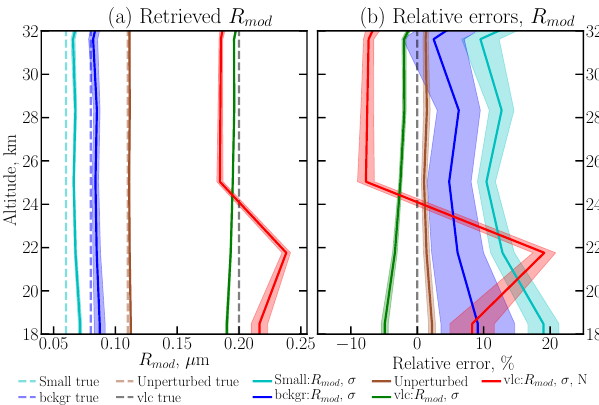
Figure 4. R mod profiles (a) and their relative errors (b) for a typi- cal tropical observation geometry. The solid lines show the retrieval results, while the dashed lines represent the true values. The shaded areas stand for ± 1 standard deviation. The scenarios used for the simulations are listed in Table 1.